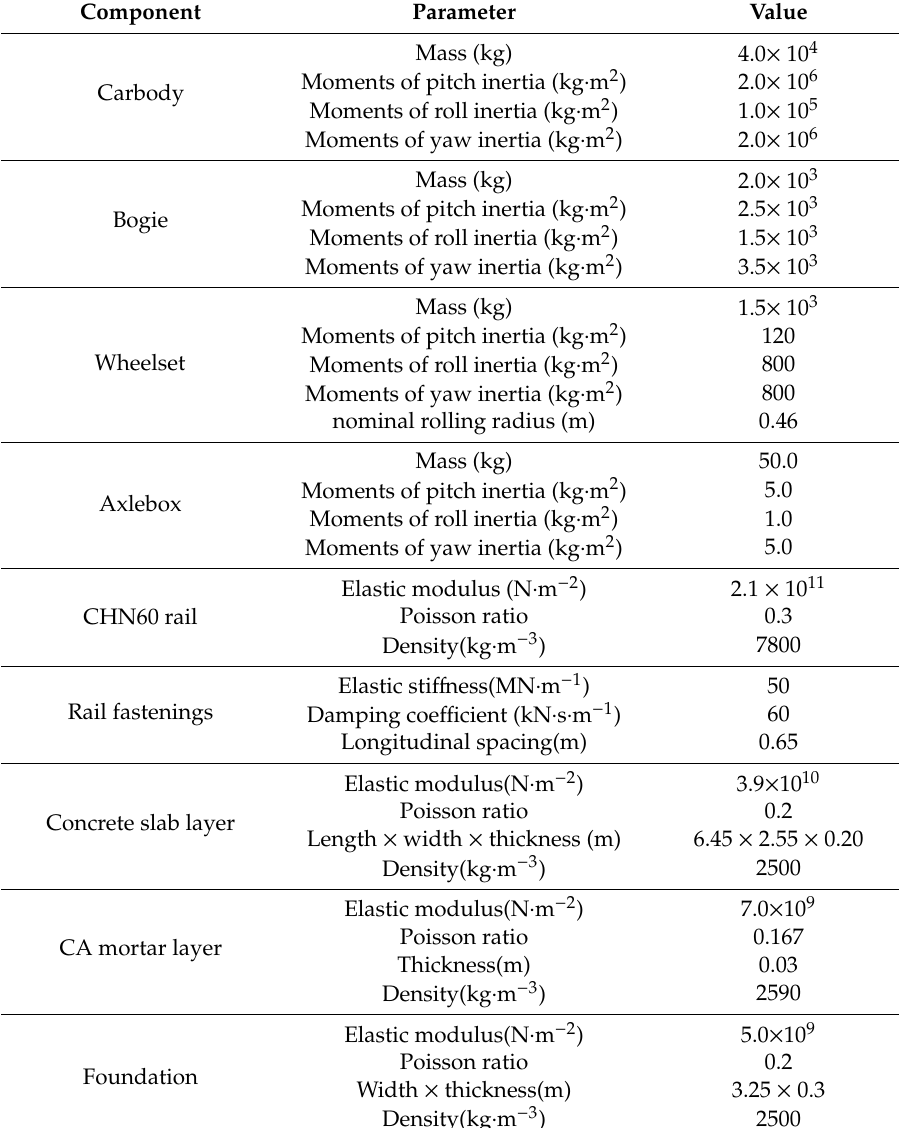
Table 1. Parameters of vehicle and track